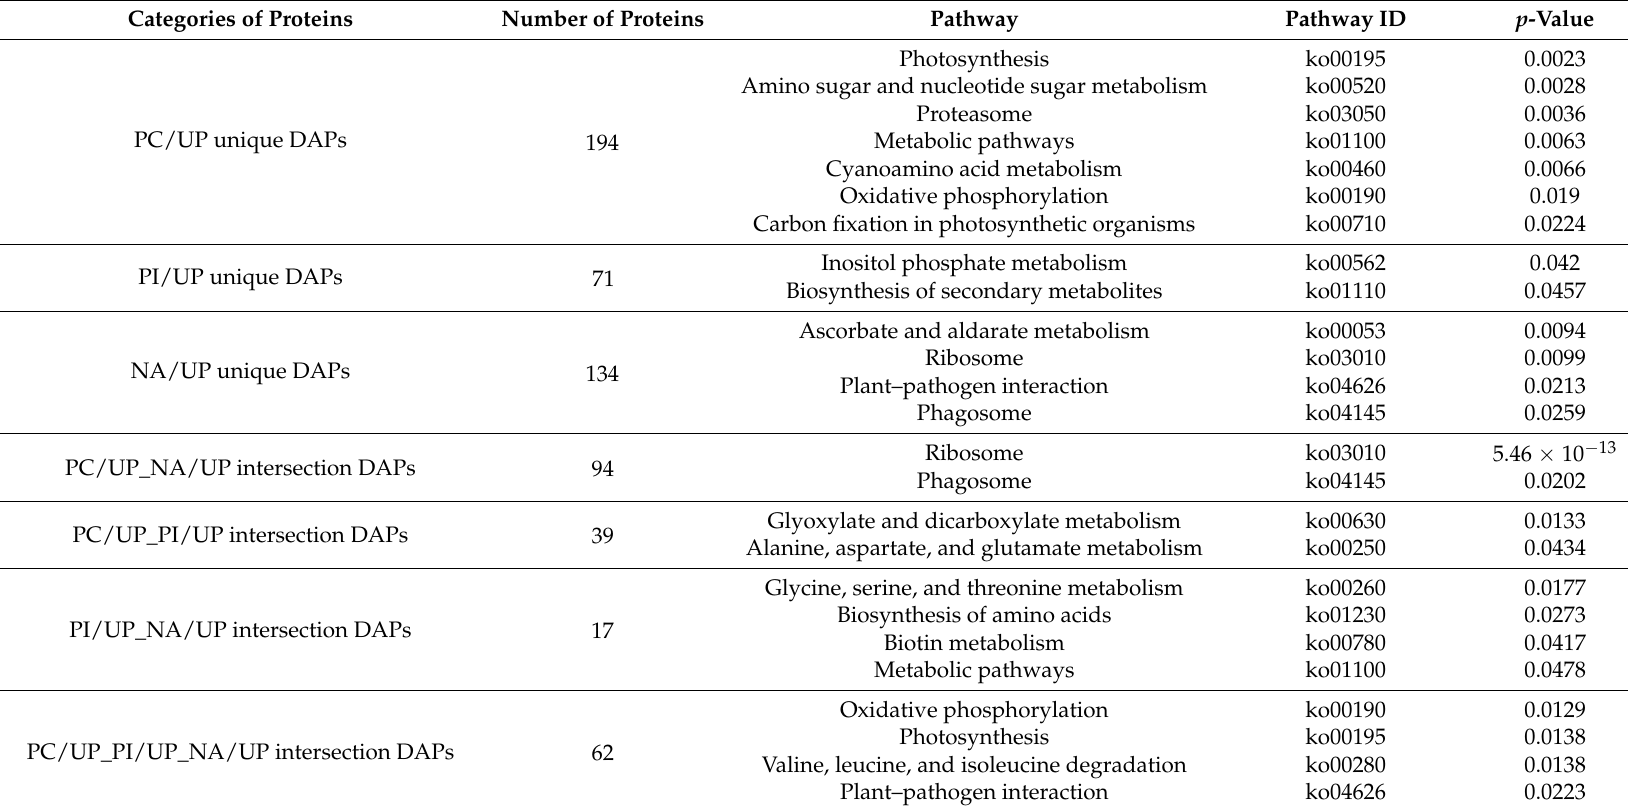
Table 1. KEGG pathway enrichment analysis of differentially accumulated proteins based on the Venn